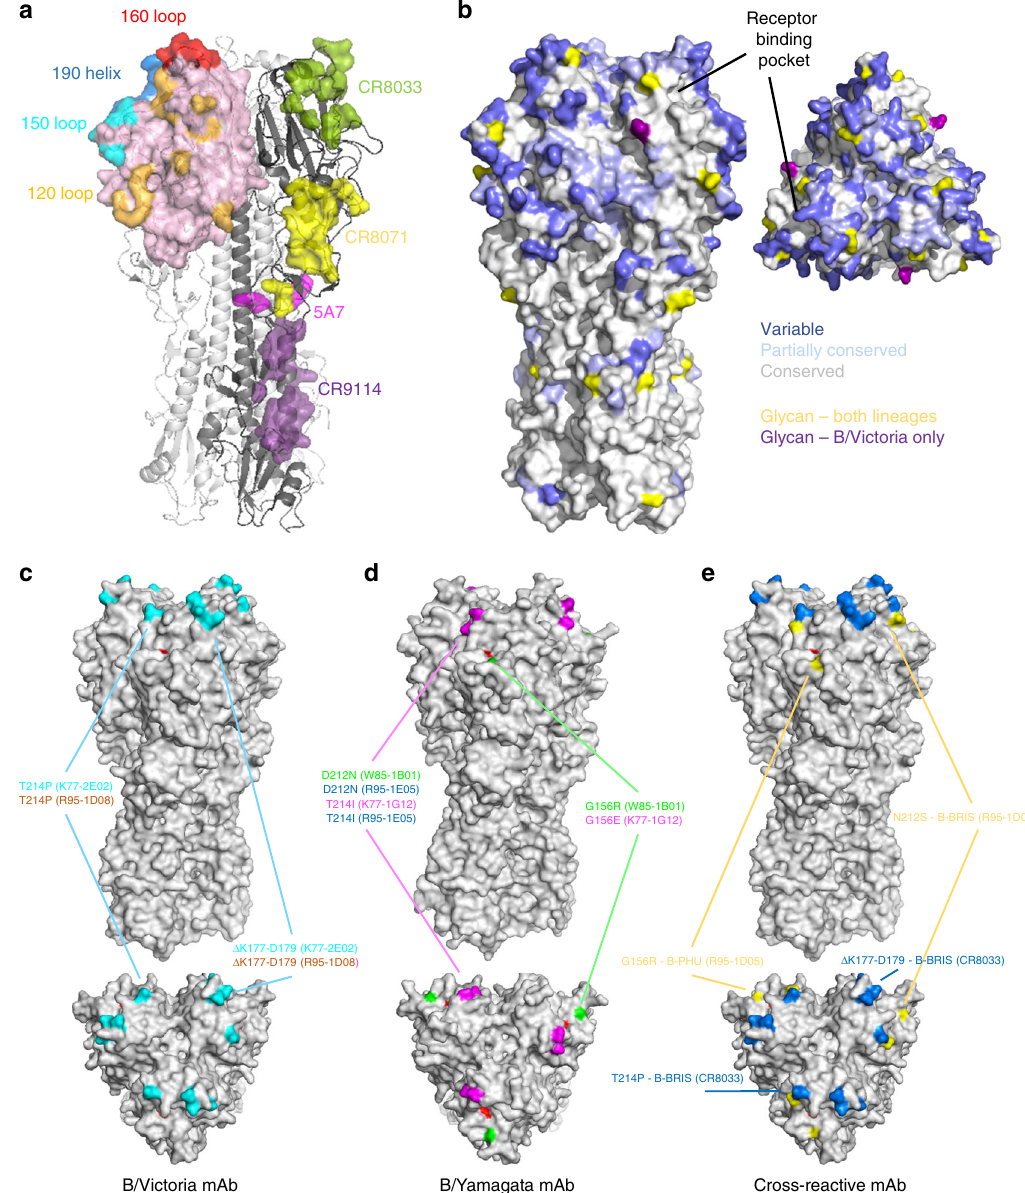
Fig. 6 Areas of the IBV HA allowing cross-reactive recognition and/or escape from human mAbs. a Surface representation illustration of canonical epitopes localised within the receptor binding domain (190-helix, 160-loop, 150-loop, 120-loop) shown on the HA trimer of B/Brisbane/60/2008 (PDB:4FQM). The resolved epitopes of broadly cross-reactive mAbs CR8033, CR8071, 5A7 and CR9114 are illustrated on the adjacent protomer. b Amino acid conservation across IBV strains ( N = 1000 per lineage) is illustrated on the B/Brisbane/60/2008 HA trimer with shading indicating areas of low (<90%), partial (>90%) and near complete conservation. Sites of N-linked glycosylation are indicated for both lineages (yellow) and for B/Victoria only (purple). c Escape mutations elicited by B/Victoria-speci fi c mAbs are mapped onto the HA of B/Brisbane/60/2008 (PDB:4FQM). F95 within the receptor binding pocket indicated in red. d Escape mutations elicited by B/Yamagata-speci fi c mAbs are mapped onto the HA of B/Yamanashi/166/1998 (PDB:4M40). e Escape mutations elicited by cross-reactive mAbs are indicated on